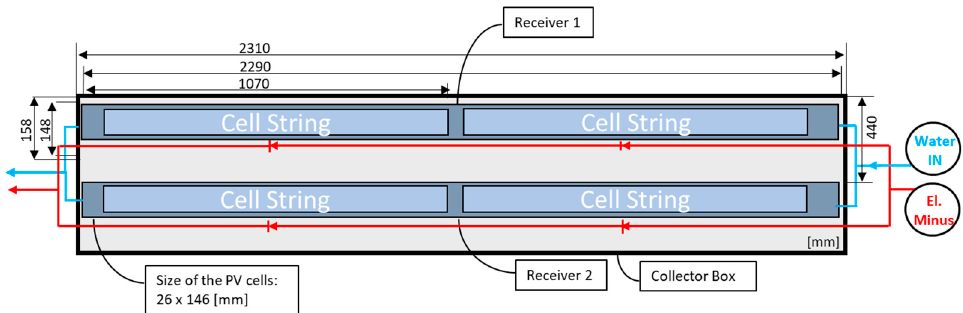
Figure 1. Top view of the C-PVT collector. The water connections are marked in blue and the electrical connections in red [2].